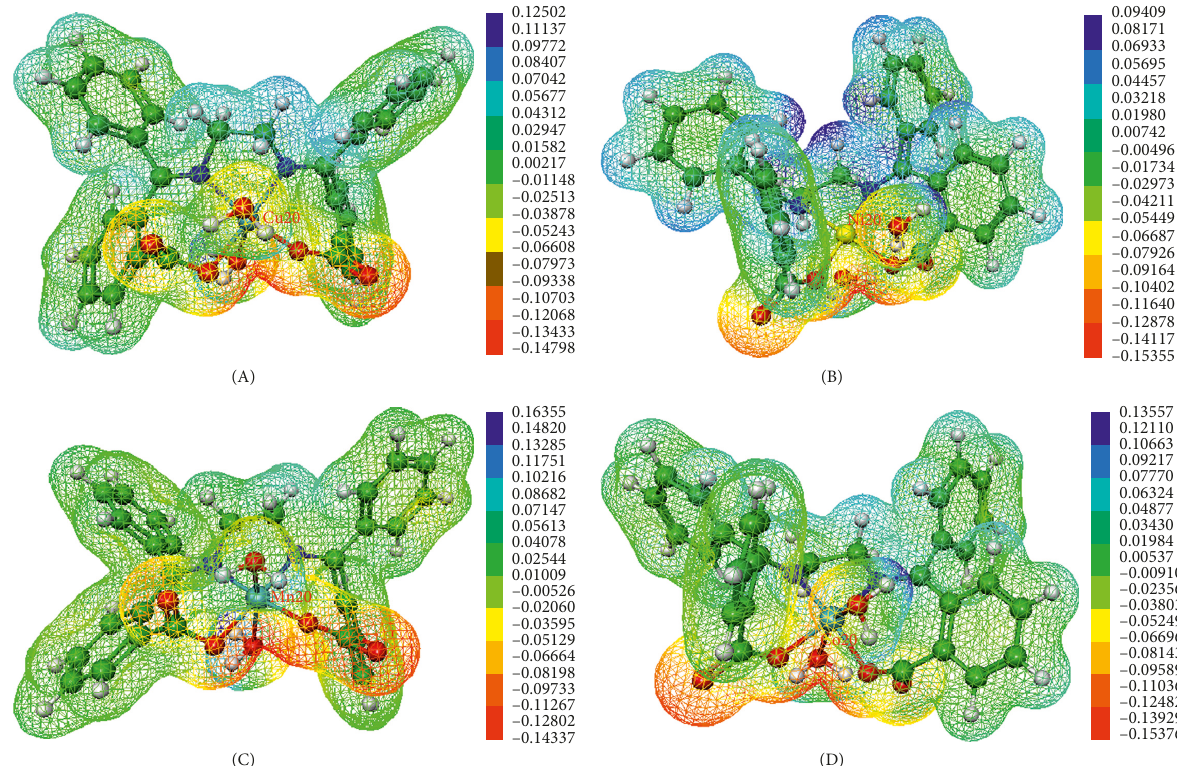
Figure 4: Molecular electrostatic potential (MEP) surfaces of EDA2BB complexes, mapped onto electron density isosurfaces of value 0.01au, using Molekel